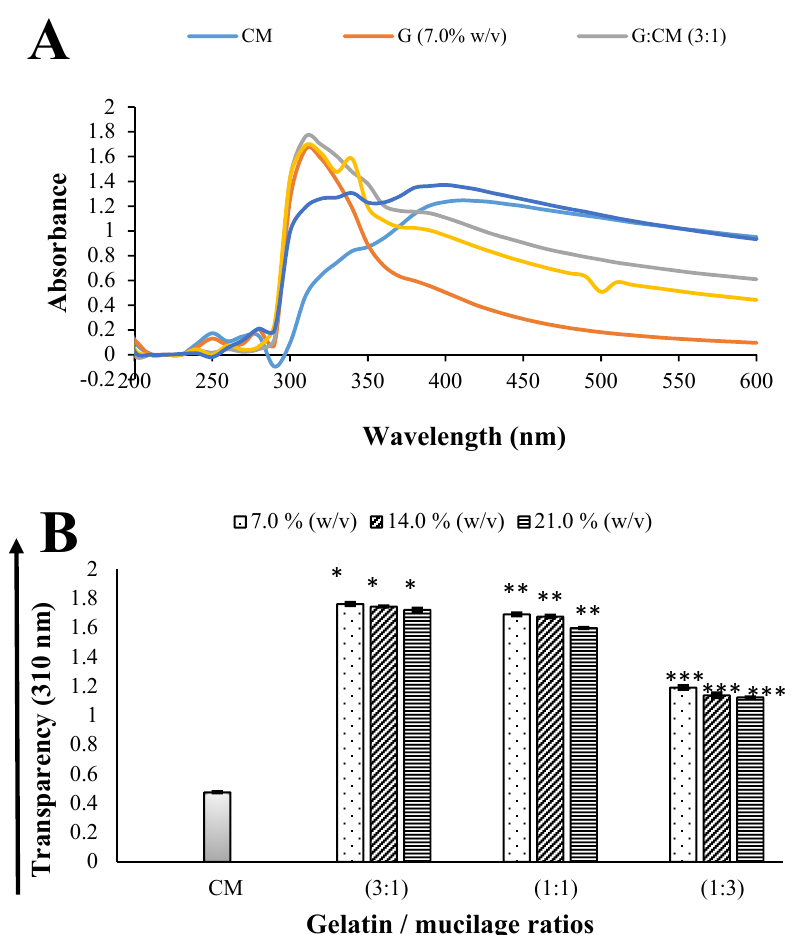
Figure 1. Ultraviolet (UV)-visible absorbance spectra ( A ) and transparency at 310 nm ( B ) of soft capsule-forming solutions as a function of concentration of Gelatin (G) and of the gelatin / cactus mucilage (G / CM) ratios (3:1, 1:1 and 1:3). All data are the mean of measurements (n = 3) ± standard deviation. Different asterisks in the same column for each solution indicate a statistical difference ( p < 0.05) between samples.